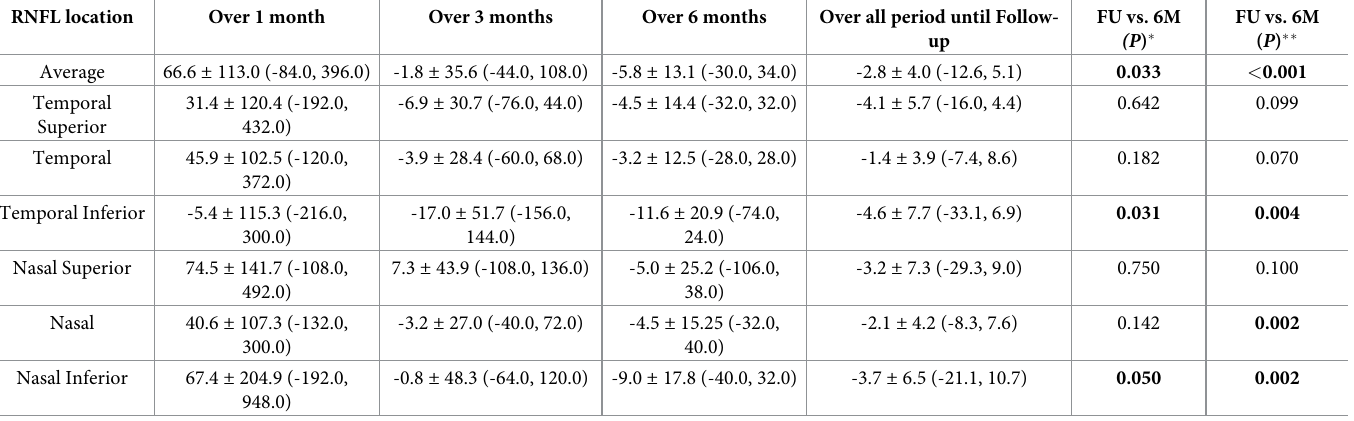
Table 2. The rate (speed) of retinal nerve fiber layer thinning over time. The units are μ m per year. Positive values correspond to thickening while negative values cor- respond to thinning. RNFL